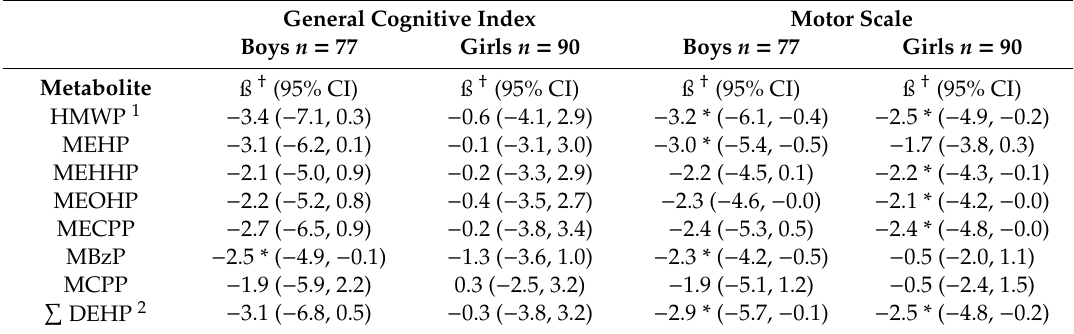
Table 3. Regression coe ffi cients † for first trimester ln-unit increase in urinary phthalate metabolite concentration associated with McCarthy Scales of Children’s Abilities, stratified by sex †